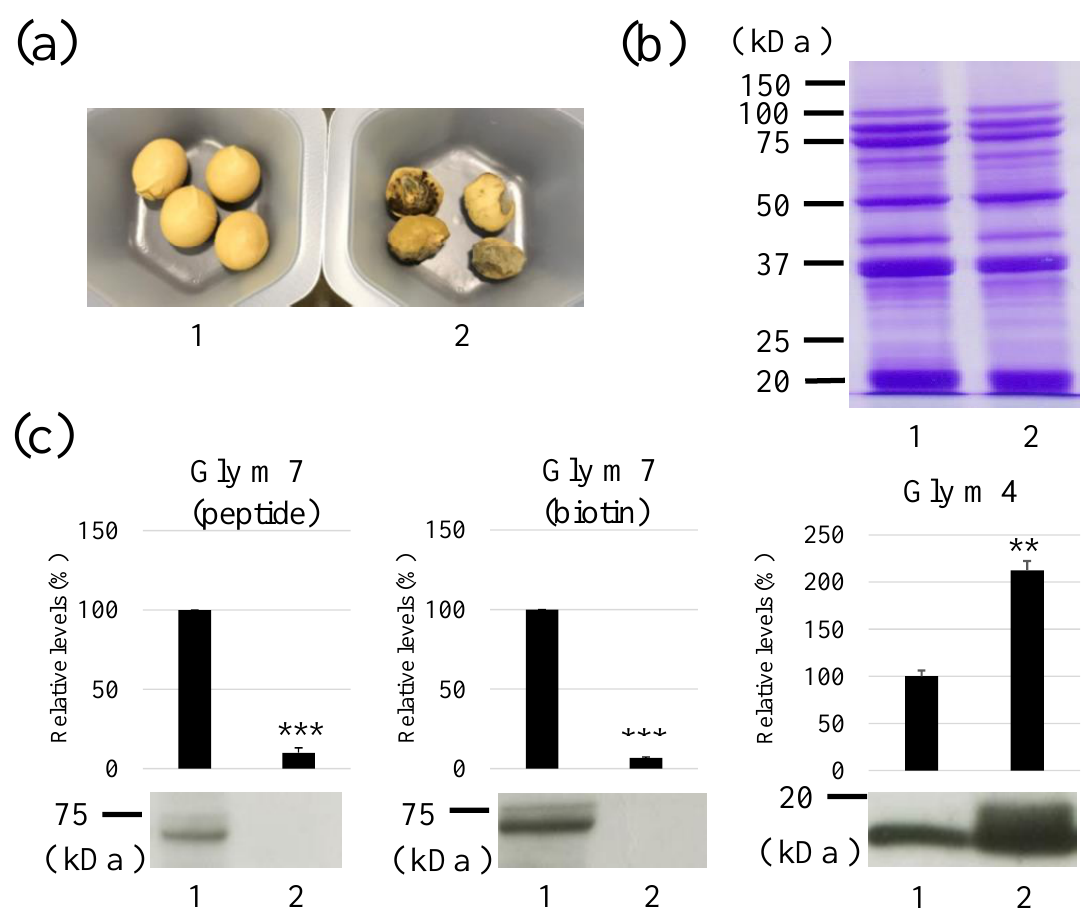
Figure 7. Effect of worm wounding on the Gly m 7 and Gly m 4 allergen levels. Appearance ( a ) and protein profiled by Coomassie Brilliant Blue (CBB) staining ( b ), Gly m 7 and Gly m 4 levels detected by antibody or horseradish peroxidase (HRP)-labeled streptavidin of non-wounded (1) and worm-wounded mature soybeans (2) ( c ). Total proteins were extracted from mature soybeans (non-wounded and worm-wounded) and subjected to sodium dodecyl sulphate–polyacrylamide gel electrophoresis (60 µ g/lane). Total protein was stained with CBB G-350, and Gly m 7 was detected by anti-Gly m 7 or HRP-labeled streptavidin as described in the Materials and Methods. Similarly, Gly m 4 levels were detected by anti-Gly m 4 antibody. Detected band intensities were expressed. Lane 1, non-wounded mature soybeans; Lane 2, worm-wounded mature soybeans. ***: p < 0.0001, **: p < 0.01, student’s t test.